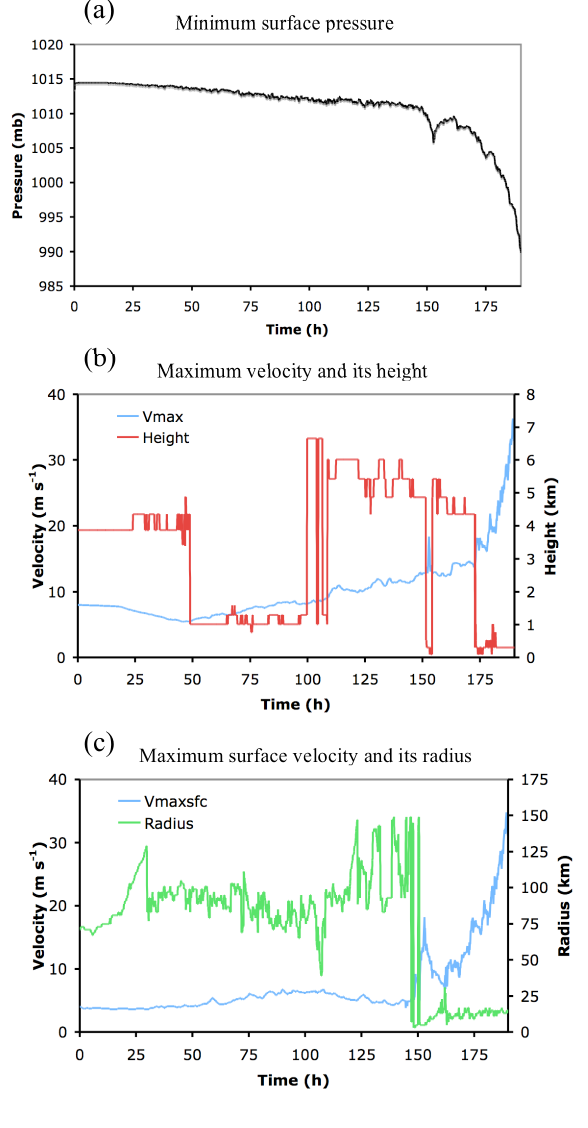
Figure 6. As in Figure 2, for Experiment 3. Fig. 6. As in Fig. 2, for Experiment